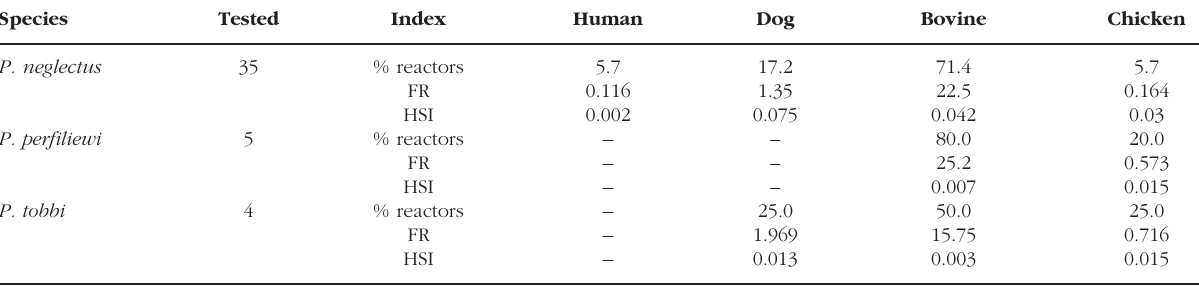
Species Tested Index Human Dog Bovine Chicken P.